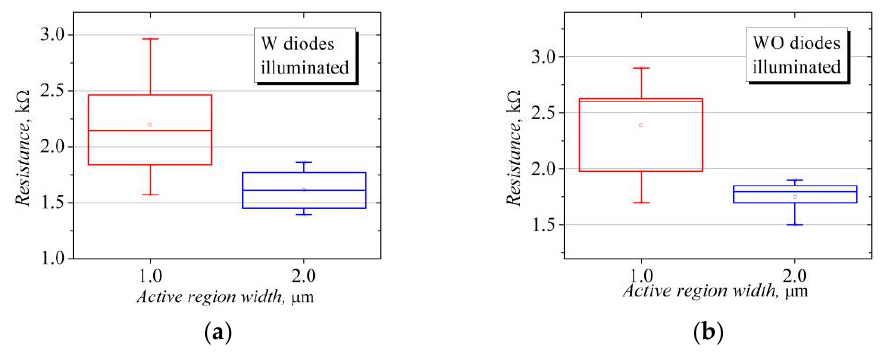
Figure A3. ( a ) The W bow‑tie diodes with InAs inserts; ( b ) the WO bow‑tie diodes without InAs